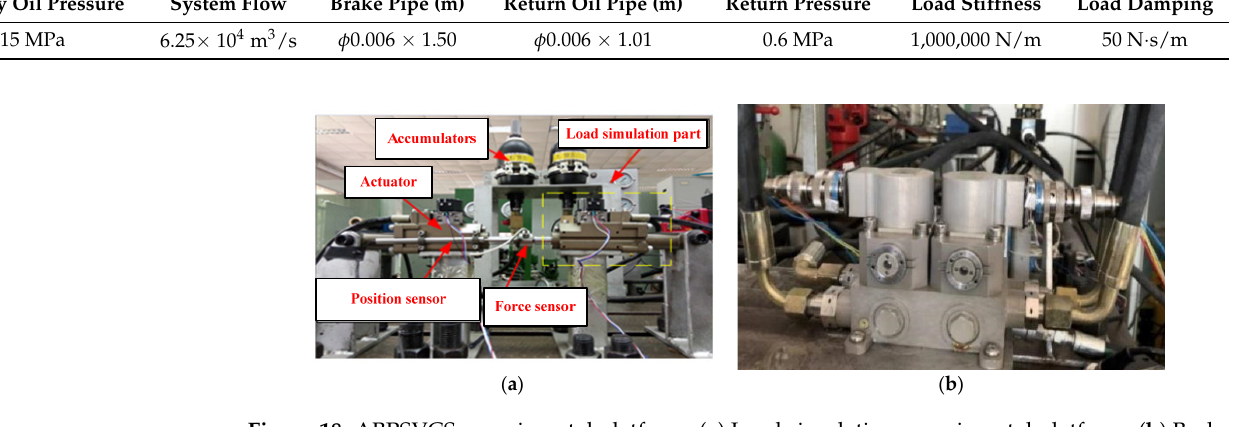
Figure 18. ABPSVCS experimental platform. ( a ) Load simulation experimental platform. ( b ) Brake pressure servo valve group.